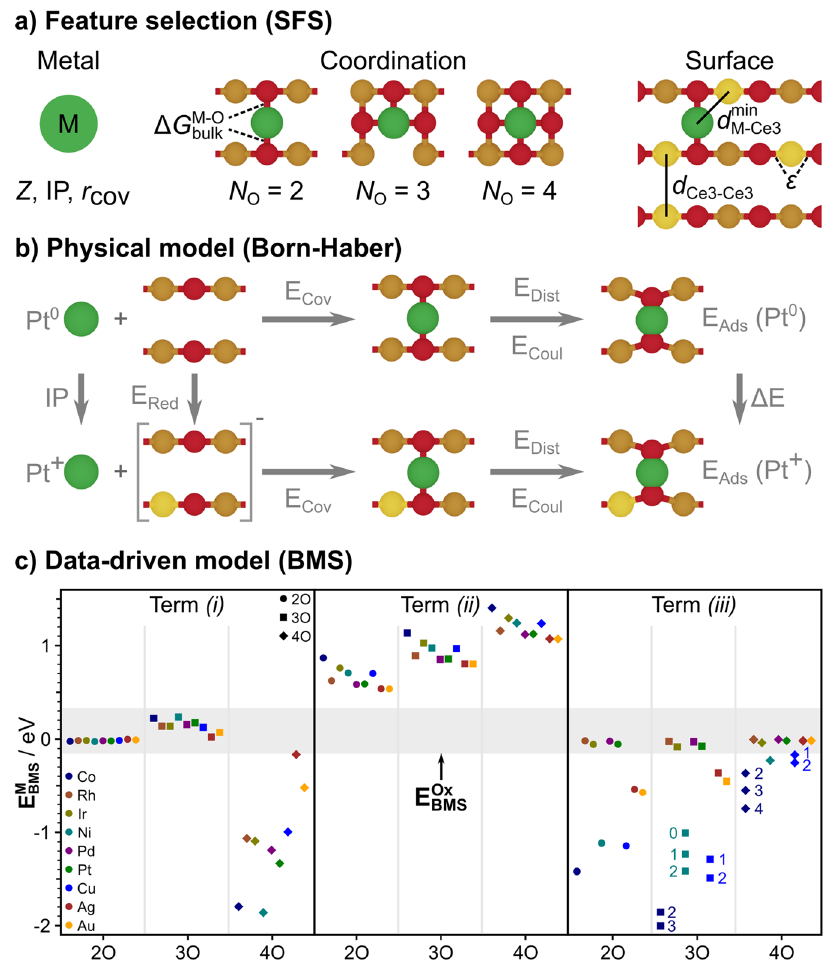
Fig. 4 Schematic of the data-driven construction of a closed-form model for the interaction of single metal atoms with the CeO 2 (100) support, obtained by the Bayesian Machine Scientist (BMS). a Representative features selected via sequential feature selection (SFS) from predictive ML models. b Physical Born – Haber model previously used to describe the metal-support interaction of a Pt 1 /CeO 2 (100) SAC at fi xed coordination and two charge states (energy terms: Red = Reduction; Cov = Covalent; Dist = Distortion; Coul = Coulomb; Ads = Adsorption). c Energy contributions given by each individual term of E M . The range of energy contribution due to the support, E Ox , is indicated as gray BMS BMS background. Relevant mOS values for term (iii) are